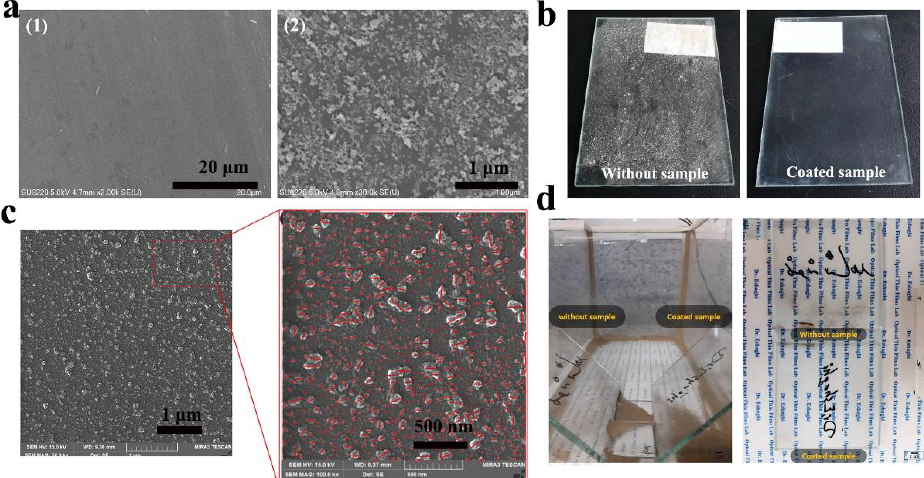
Figure 5. ( a ) (1) SEM image of a superhydrophobic surface; (2) A magnified view of (1) and ( b ) a comparative image of anti-dust properties, reproduced with permission from Ref. [94]. ( c ) SEM image of hydrophobic film and ( d ) comparison of anti-dust properties, reproduced with permission from Ref. [74].